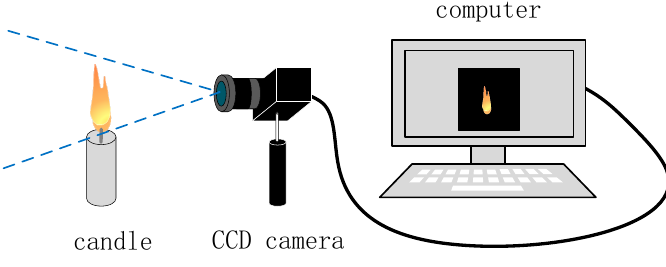
Figure 2. Schematic of the experimental system.